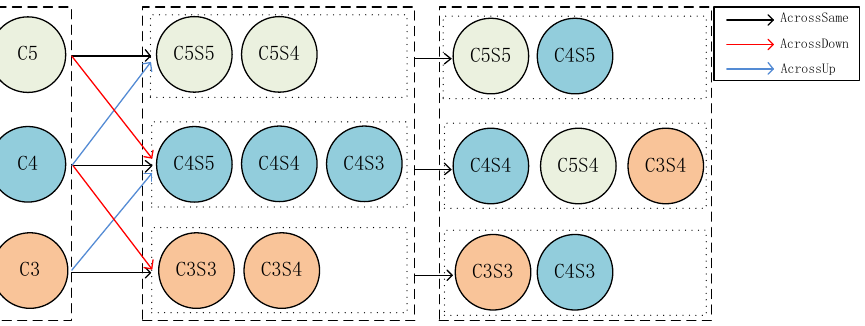
Figure 2. Feature constructor module. It consists of two sub-modules: the feature resizing module and the feature transform module. The resizing module generates different scale features by up- sampling or down-sampling. The feature transform module combines all the same scale features together to make new feature layers.